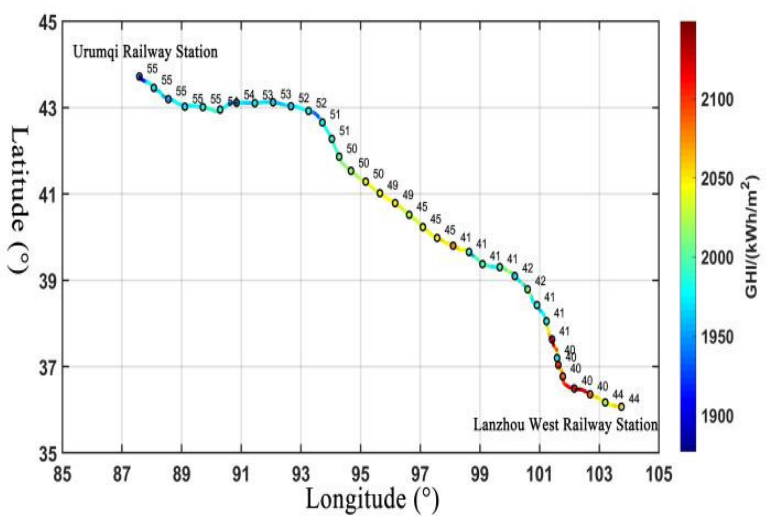
Figure 6. The optimal inclination of the traction substation and the average light intensity along the railway.